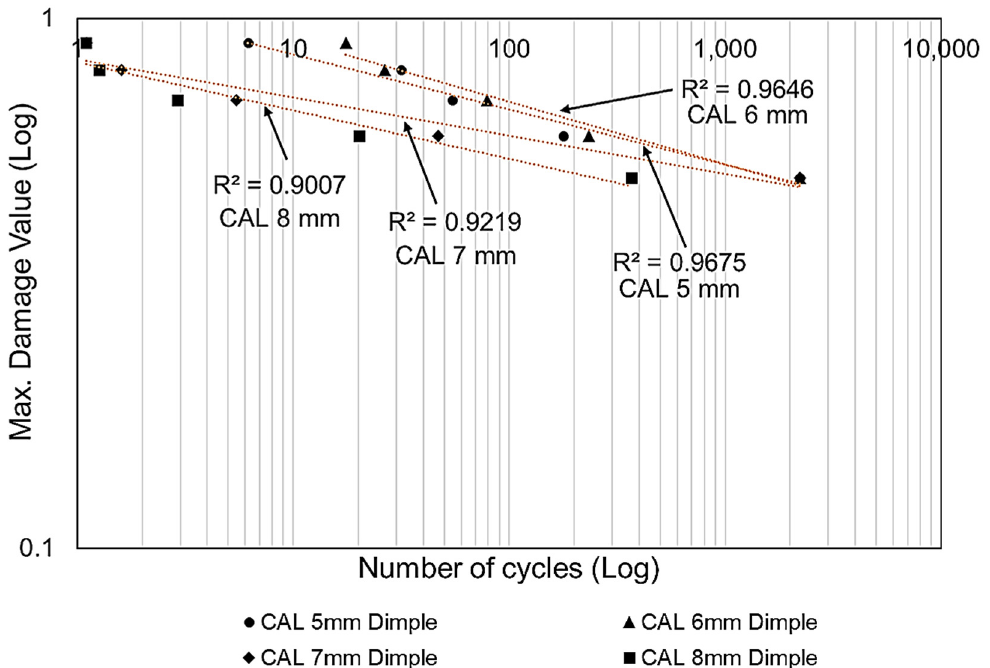
Figure 15. The model of damage in a logarithmic scale showing the maximum damage to the hotspot dimple region against the number of stress life cycles for various dimple core configurations under constant cyclic loading conditions. Table 15. Summation of FPIS and FNIS through all the main alternatives to determine the dimple core configuration ranking, based on the Closeness Coefficient analysis.